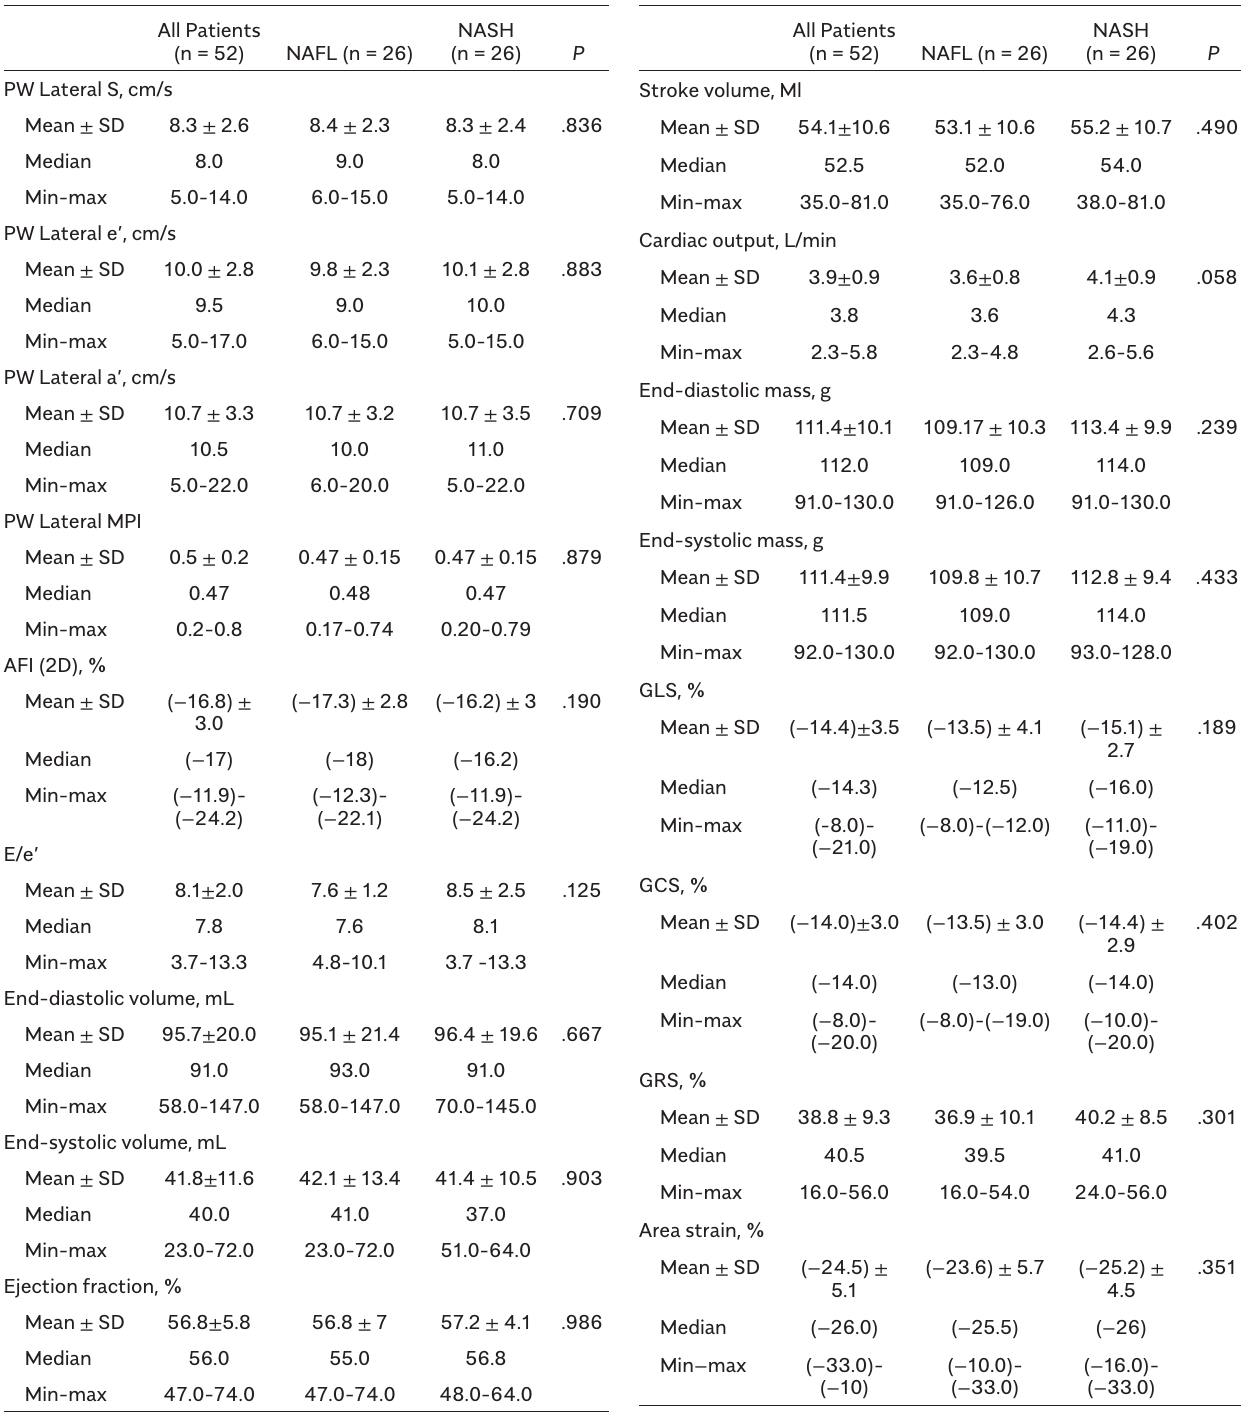
Table 4. Echocardiography and Cardiac MR Assessments of Patients ( Continued